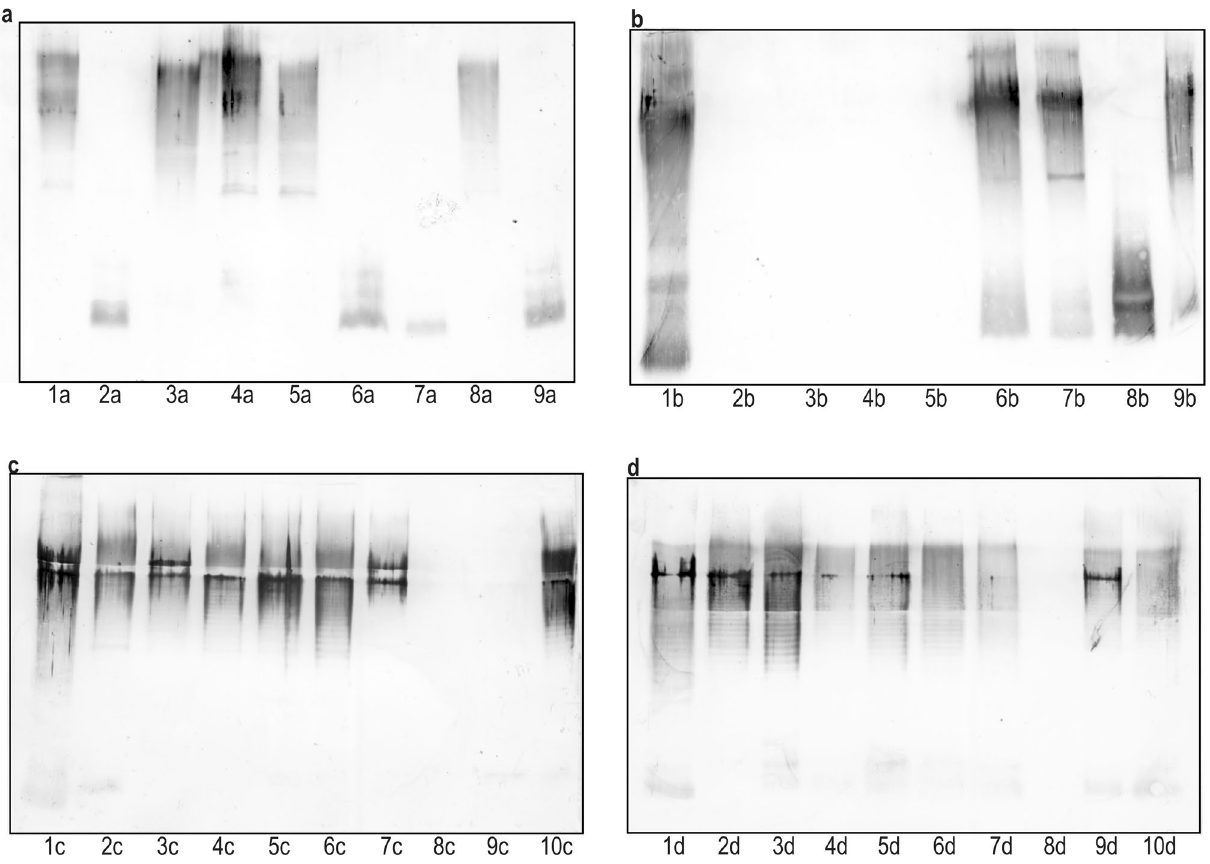
Figure 3. Western blots of homologous LPSs (1) and proteinase K-treated biomasses of selected strains (2–10) preliminarily classified to O3 serogroup ( a ), O10 serogroup ( b ), O28 serogroup ( c ), and O50 serogroup ( d ) with the respective